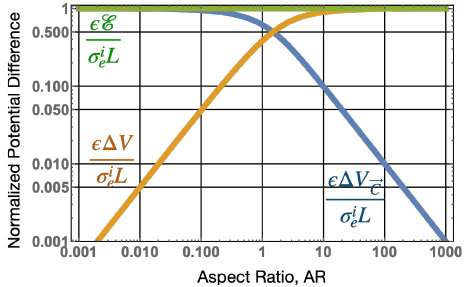
Figure 6. Normalized potential difference across the terminals an active cylindrical dipole generator versus aspect ratio. The normalized emf or voltage output, (cid:101) E is shown in green and is equal to σ i e L unity independent of aspect ratio when setting the radius of the dipole to unity. The output voltage in general has both a scalar potential and vector potential as given by Equations (39) and (40) and are plotted in orange and blue, respectively. Results show that the vector potential dominates for small aspect ratios while the scalar potential dominates for large aspect